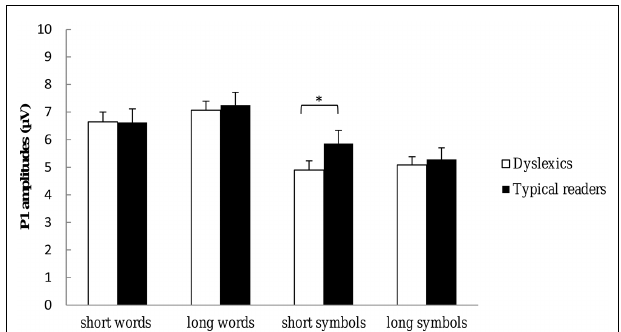
FIGURE 4 | P1 amplitudes to each of the string types and string lengths used in the present study. Open bars refer to the P1 amplitudes of dyslexic readers and filled bars to the P1 amplitudes of typical readers. P1 amplitudes are averaged acrossTP7,TP8, P9, P10, P7, P8, P5, P6, PO7, PO8, PO3, PO4, O1, and O2 electrode sites. * p < 0.05.